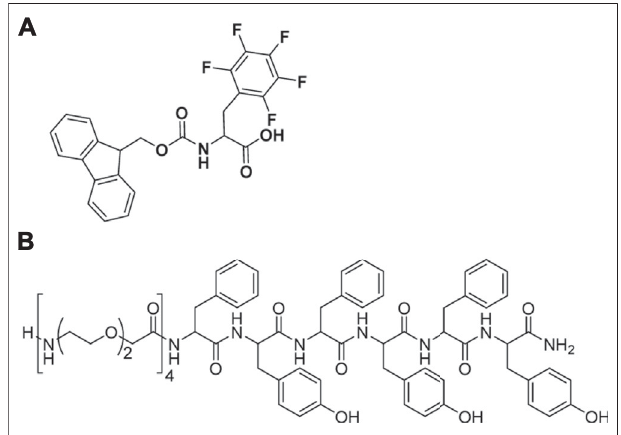
FIGURE 13 | (A) The structure of penta fl uorinated Fmoc-Phe used by Halperin-Sternfeld et al. (Halperin-Sternfeld et al., 2017); (B) The structure of PEGylated (Phe-Tyf) 3